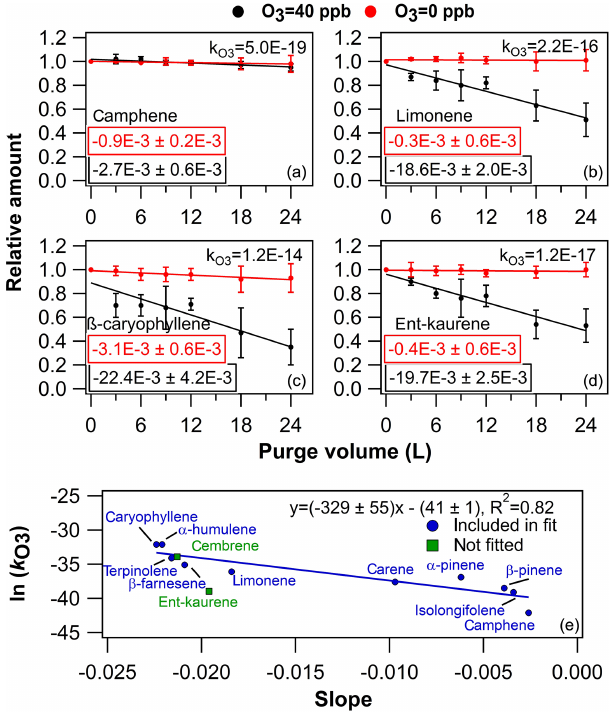
Figure 5. Results from ozone exposure experiments. In (a) , (b) , (c) and (d) examples from the ozone exposure experiments are pre- sented as the relative amount of compound in the sorbent tube as a function of purge volume. The values embedded into the plots are the linear regression fit slopes ( ± uncertainty) of corresponding conditions (either O 3 = 0 or O 3 = 40ppb). The compound-specific k O values are presented in the plots as well. The error bars rep- 3 resent reproducibility ( n = 3). In (e) is presented the literature- retrieved ln ( k O ) values (see Table S3) as a function of the linear 3 regression fit